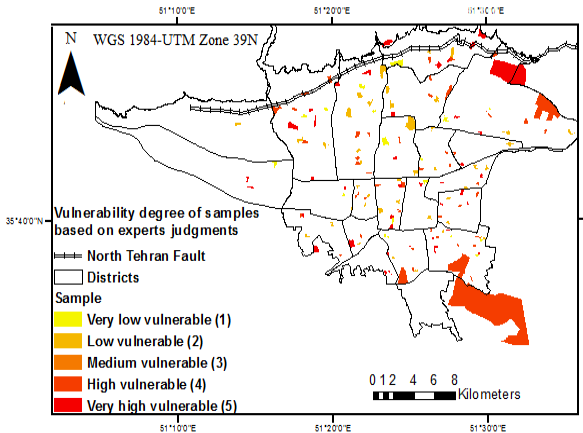
Figure 1. Position of the sample data in the study area